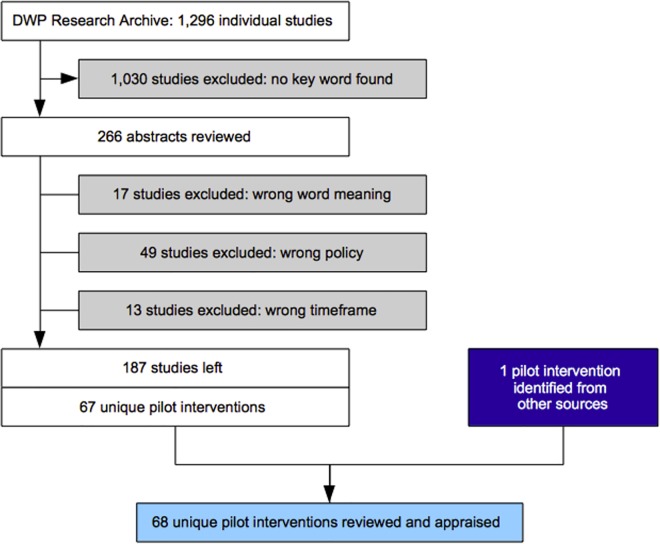
Selection process.